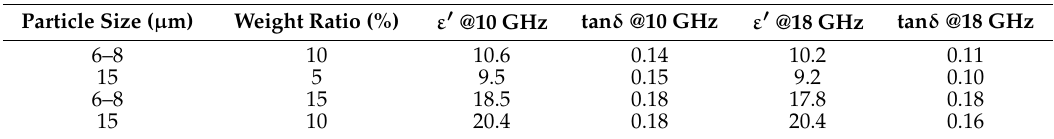
Table 2. Dielectric constant and loss tangent of epoxy resin loaded with 6–8- µ m and 15- µ m graphene particle sizes with various weight ratios.